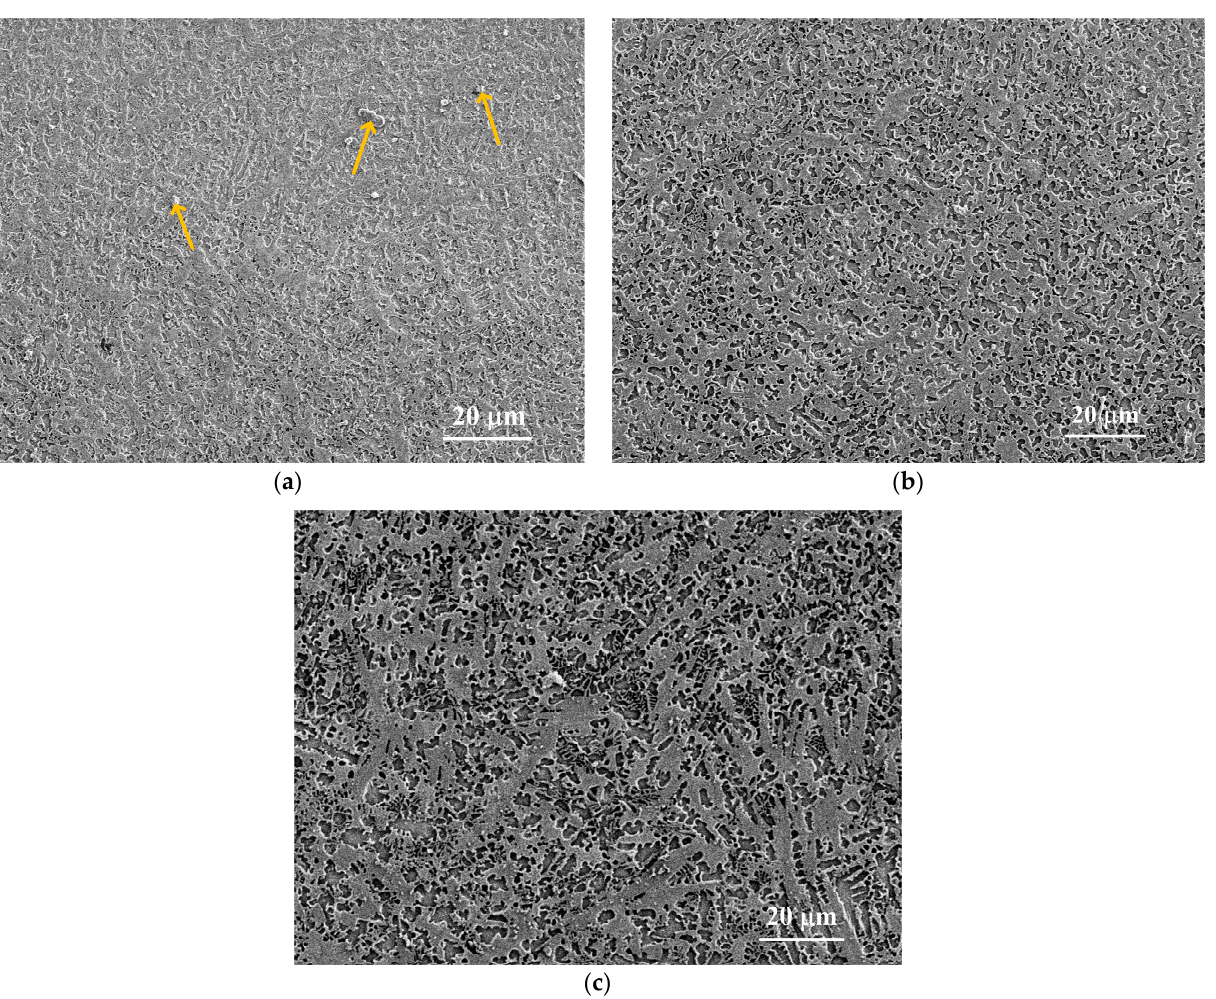
Figure 7. The dendrite morphology of the coating from top to bottom: ( a ) dendrite morphology in the top of the coating (Yellow arrows indicate particles at the top of the coating); ( b ) dendrite morphology in the middle of the coating; ( c ) dendrite morphology in the bottom of the coating.